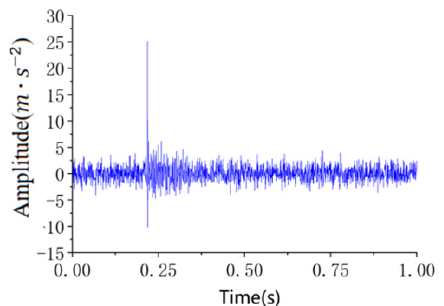
Figure 12. Time domain diagram of test bearing vibration signal.